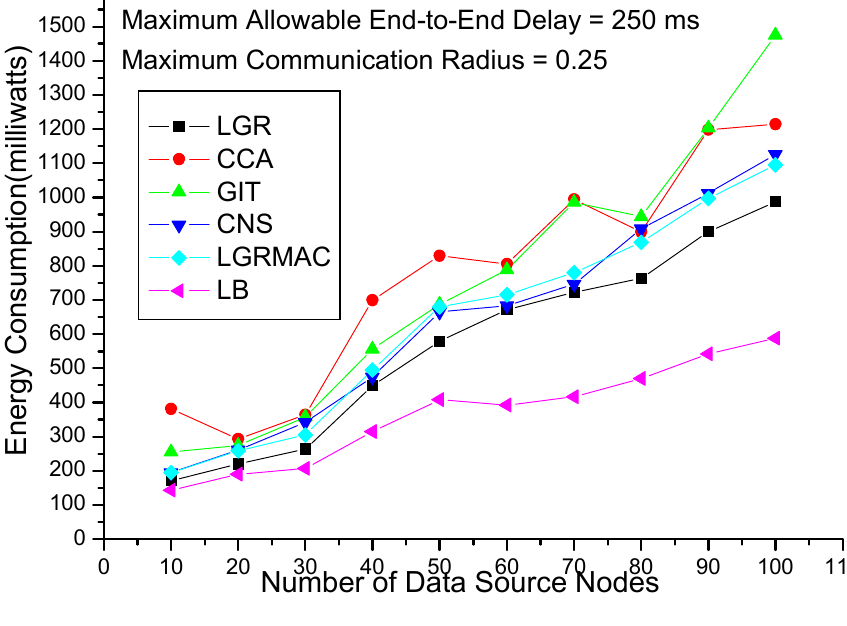
Figure 4. Performance comparison with respect to traffic